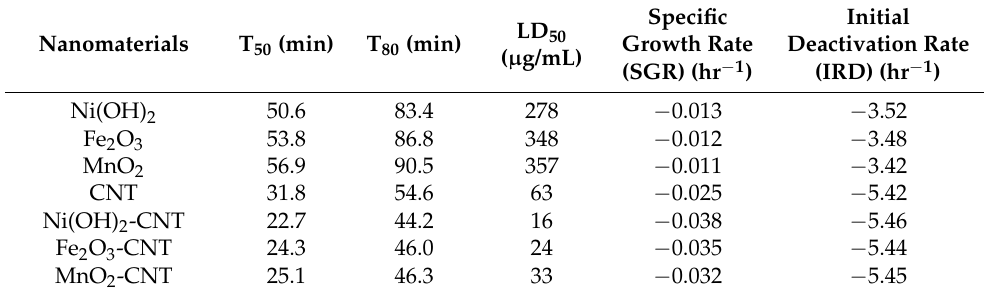
Table 2. Phage virus inactivation kinetic